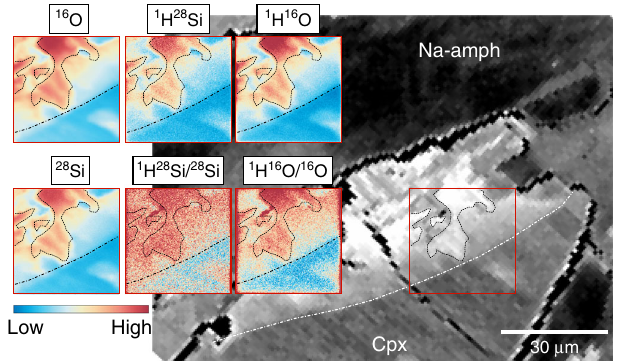
Fig. 3 BSE image and Nano-SIMS measurements of a clinopyroxene crystal affected by the fl uid in fl ux and surrounded by newly formed sodic amphibole. The brighter areas in the BSE image are marked by a sharp reaction front (dash-dotted line) behind which the cpx crystal has a pathy zoning. The reaction front and the patchy areas (stippled outlines) are clearly re fl ected in the isotope images. The bright areas in the BSE image correspond with elevated hydrogen contents (indicated by the 1 H 28 Si/ 28 Si and 1 H 16 O/ 16 O mappings) in the nominally anhydrous cpx. Clinopyroxene is de fi ned as Cpx and sodic amphibole as